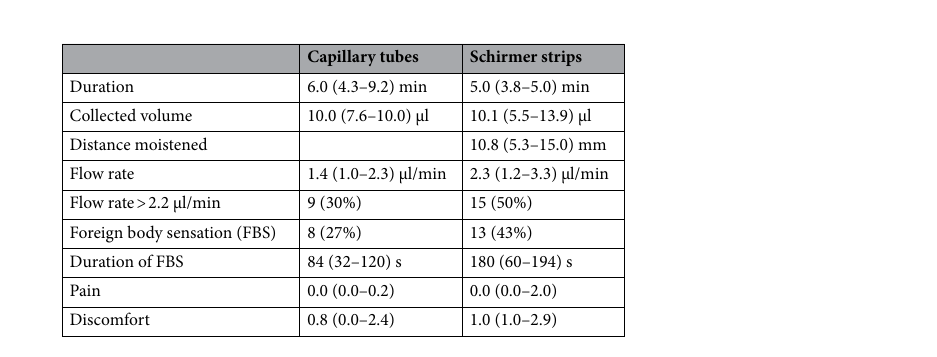
(Fig. 3a) and no correlation ( r s = 0.13, p = 0.57) with protein concentration (Fig. 3c). Tear flow rates of samples collected with Schirmer strips showed a moderate correlation ( r s = − 0.61, p = 0.004) with IgG concentration (Fig. 3b) and a strong correlation ( r s = 0.74, p = 0.0002) with protein concentration (Fig. 3d). No correlation between total protein and IgG concentrations was observed for capillary tubes ( r s = 0.06, p = 0.80) (Fig. 3e) and a moderate correlation ( r s = 0.52, p = 0.02) for Schirmer strips (Fig. 3f).